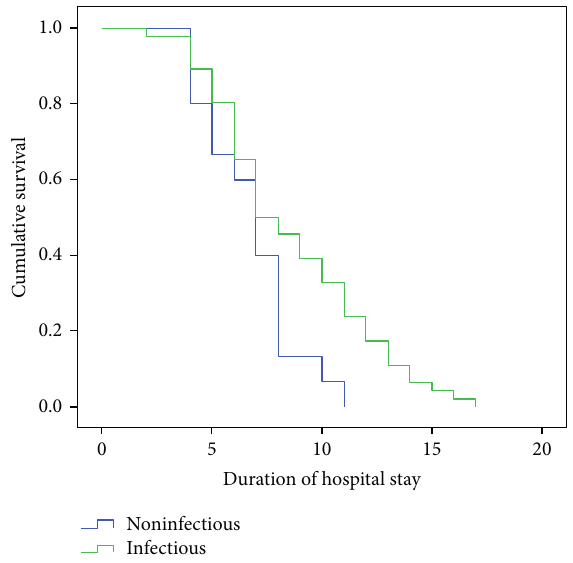
Figure 1: Timing of hospital stay in patients with infectious and noninfectious causes (Kaplan-Meier